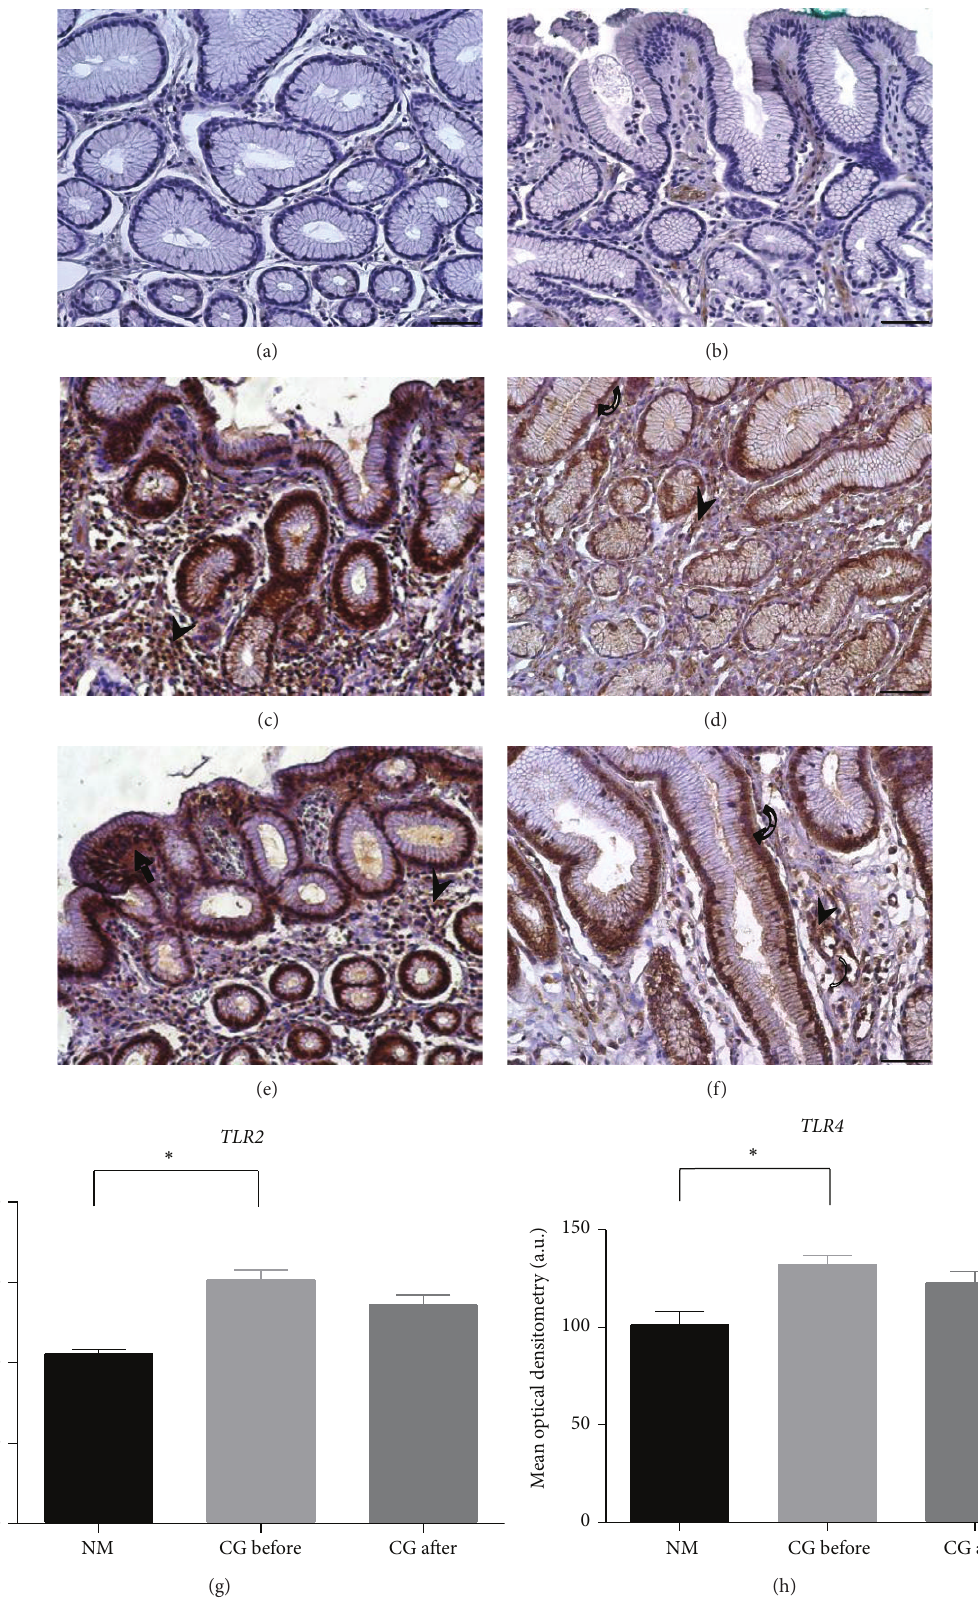
Figure 2: Immunohistochemistry images of Toll-like receptors (TLRs) in normal gastric mucosa (NM) and chronic gastritis (CG). Normal mucosa((a)TLR2and(b)TLR4);normalglandswithnostainingorlowexpressionintensity; H.pylori -positivechronicgastritis((c)TLR2and (d) TLR4); foveolar epithelial cells and glands before treatment, presenting moderate to strong TLR expression compared to normal mucosa; ((e) TLR2 and (f) TLR4); foveolar epithelial cells and glands after bacteria eradication (no significant reduction of protein expression was detected). Counterstain: hematoxylin. Bars: 50 𝜇 m. ((g)-(h)) Densitometry analyses (mean ± SE). ∗ 𝑃 < 0.05 . a.u. = arbitrary